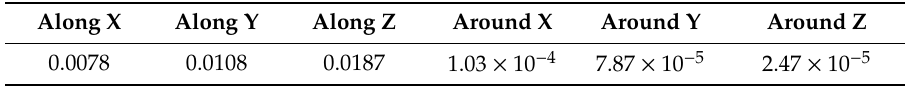
Table 5. Comparison of the root mean square errors between steady-state response and acquisition